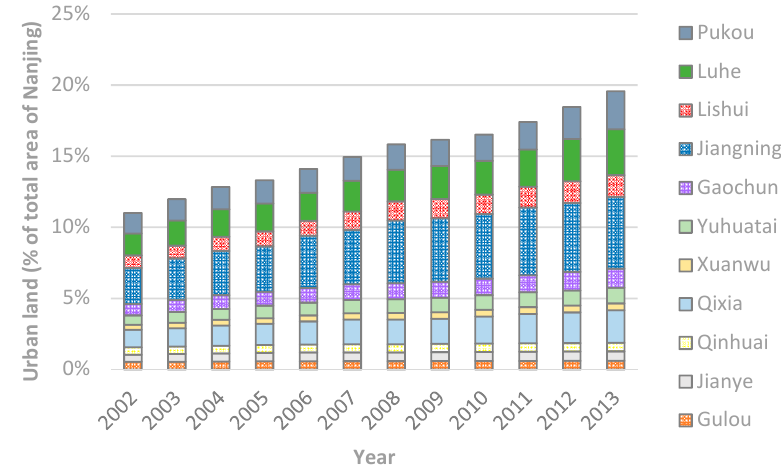
Figure 9. Temporal variations of urban land (2002–2013).